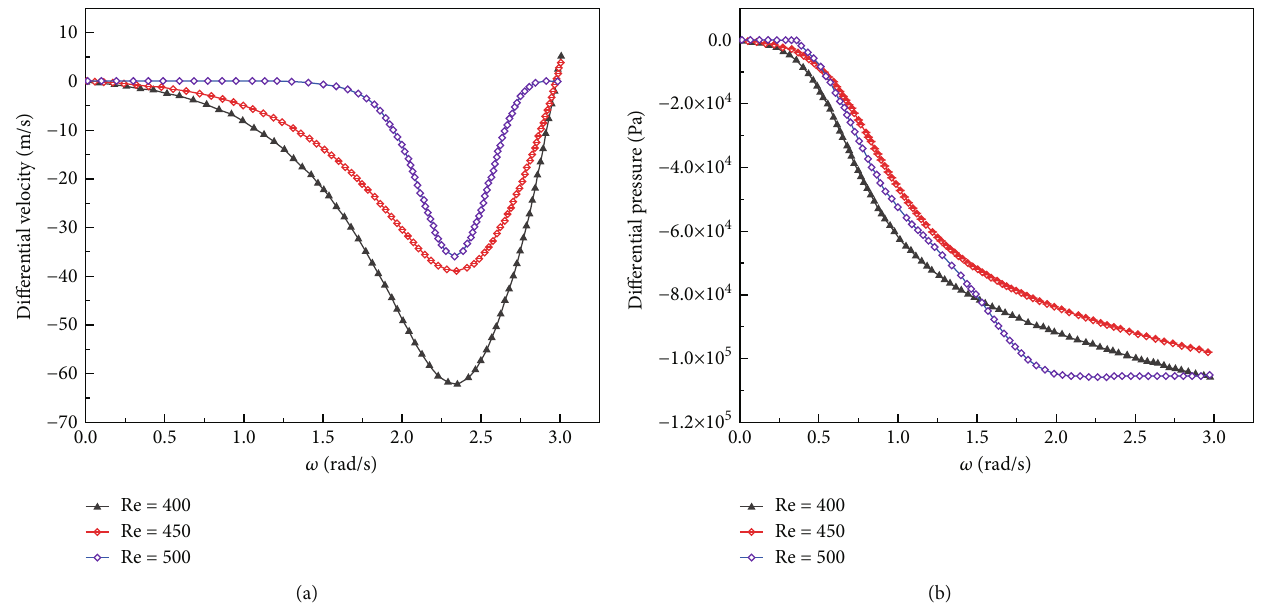
Figure 6: Distribution of the oscillating fl ow fi eld in a fi xed-section pipe at a certain time.